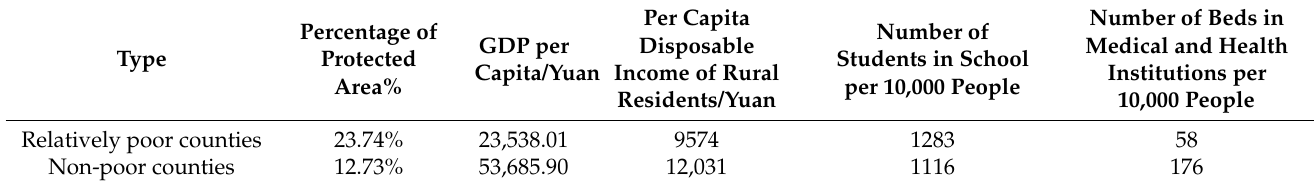
Table 6. Comparison between relatively poor and non-poor counties in